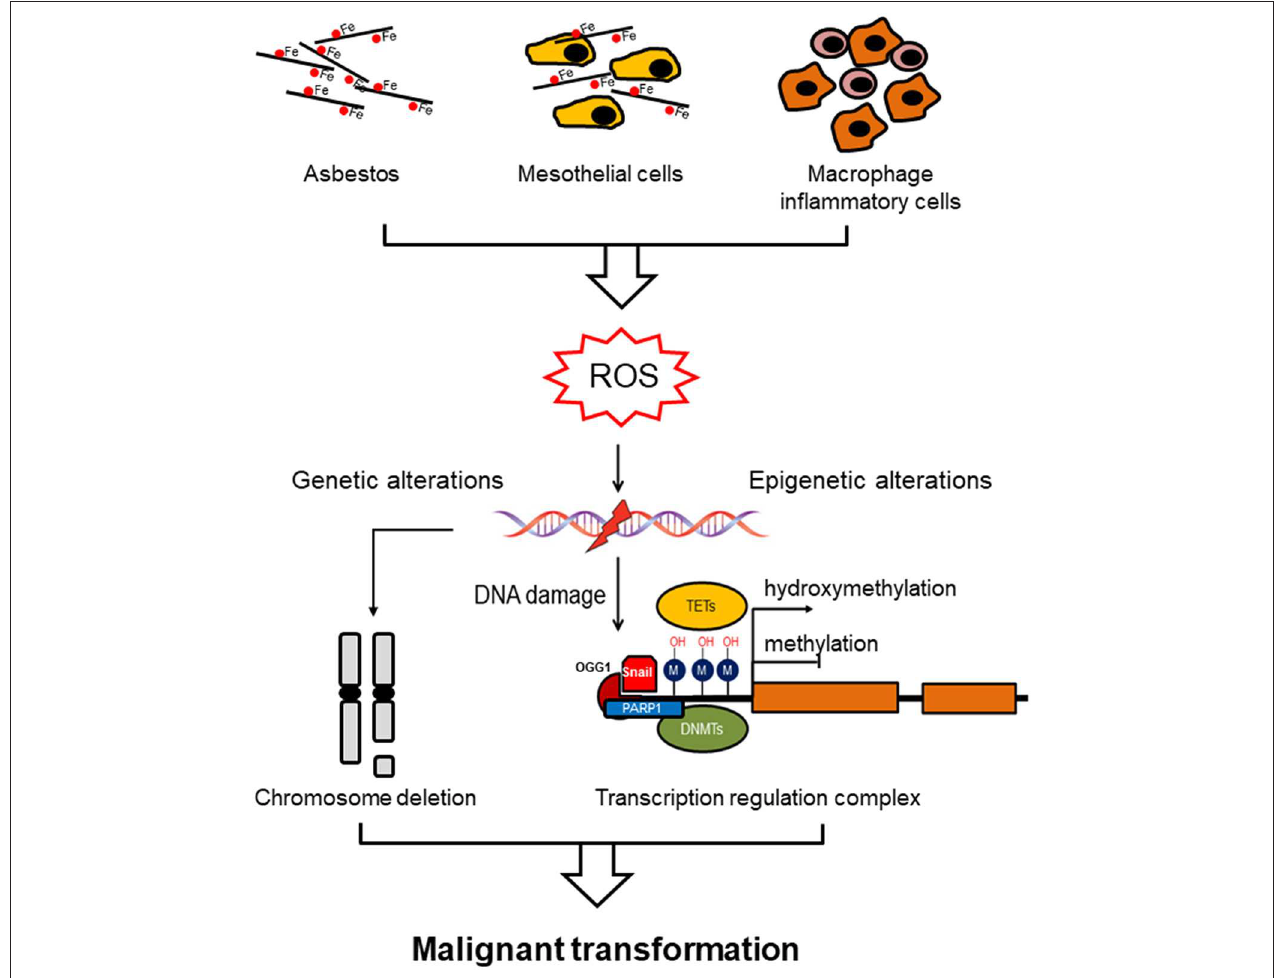
FIGURE 1 | Asbestos induces genomic/epigenomic alterations driving malignant mesothelioma. Asbestos exposure induces ROS formation directly via the iron-induced Fenton reaction or indirectly by chronic inflammation (mesothelial cells and macrophages inflammatory cells). ROS exposure induces methylation of the gene promoter via a specific recognition site to which DNMT1 and PARP1 are recruited, linking DNA damage and DNA methylation. Alternatively, prolonged ROS exposure induces demethylation by oxidizing the 5-methycytosine to produce 5-hydroxymethylcytosine, which is catalyzed by ten-eleven translocation methylcytosine dioxygenase (TET) family of enzymes. Hypomethylation of genomic DNA is associated with genomic instability, which in combination with genetic alterations (chromosome deletion), both contribute to malignant